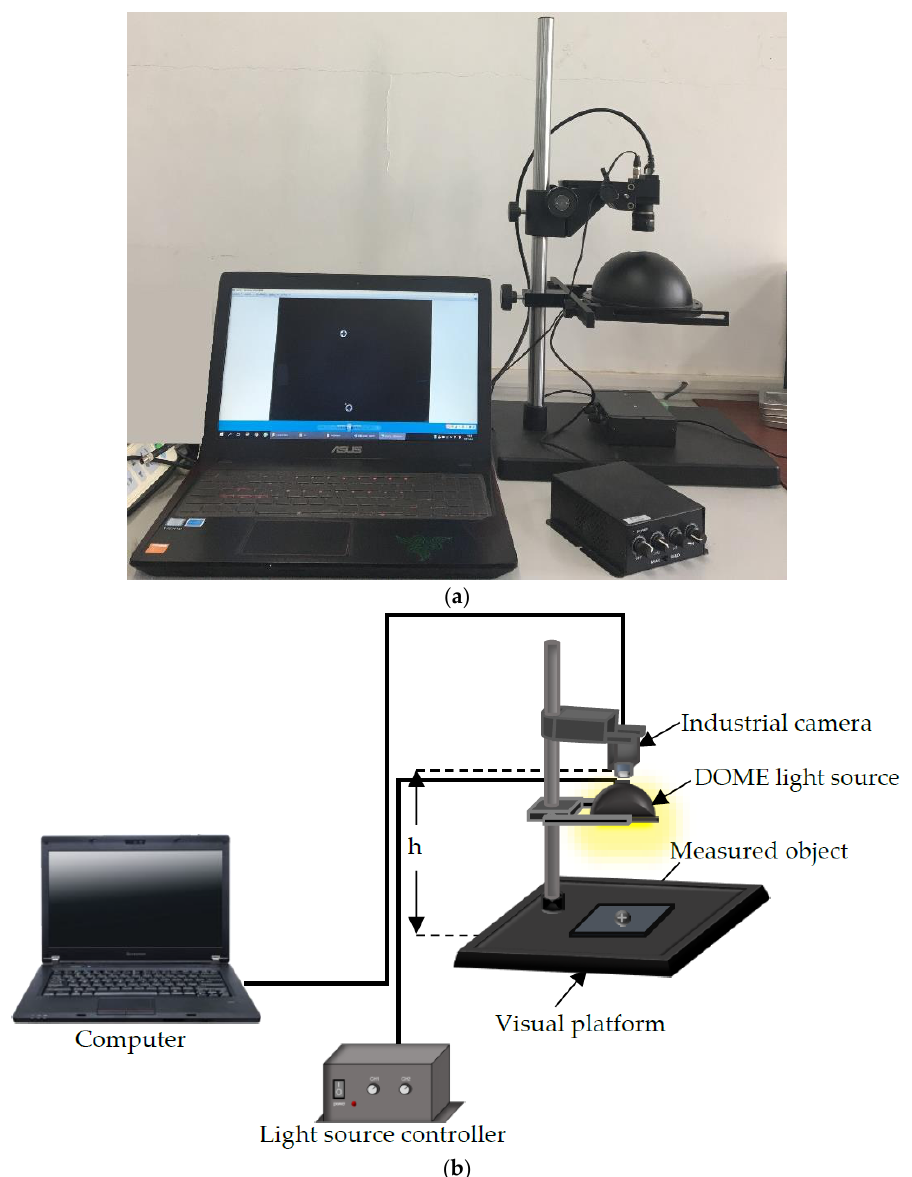
Figure 1. Experimental system for image acquisition. ( a ) Detection system, ( b ) System structure diagram.